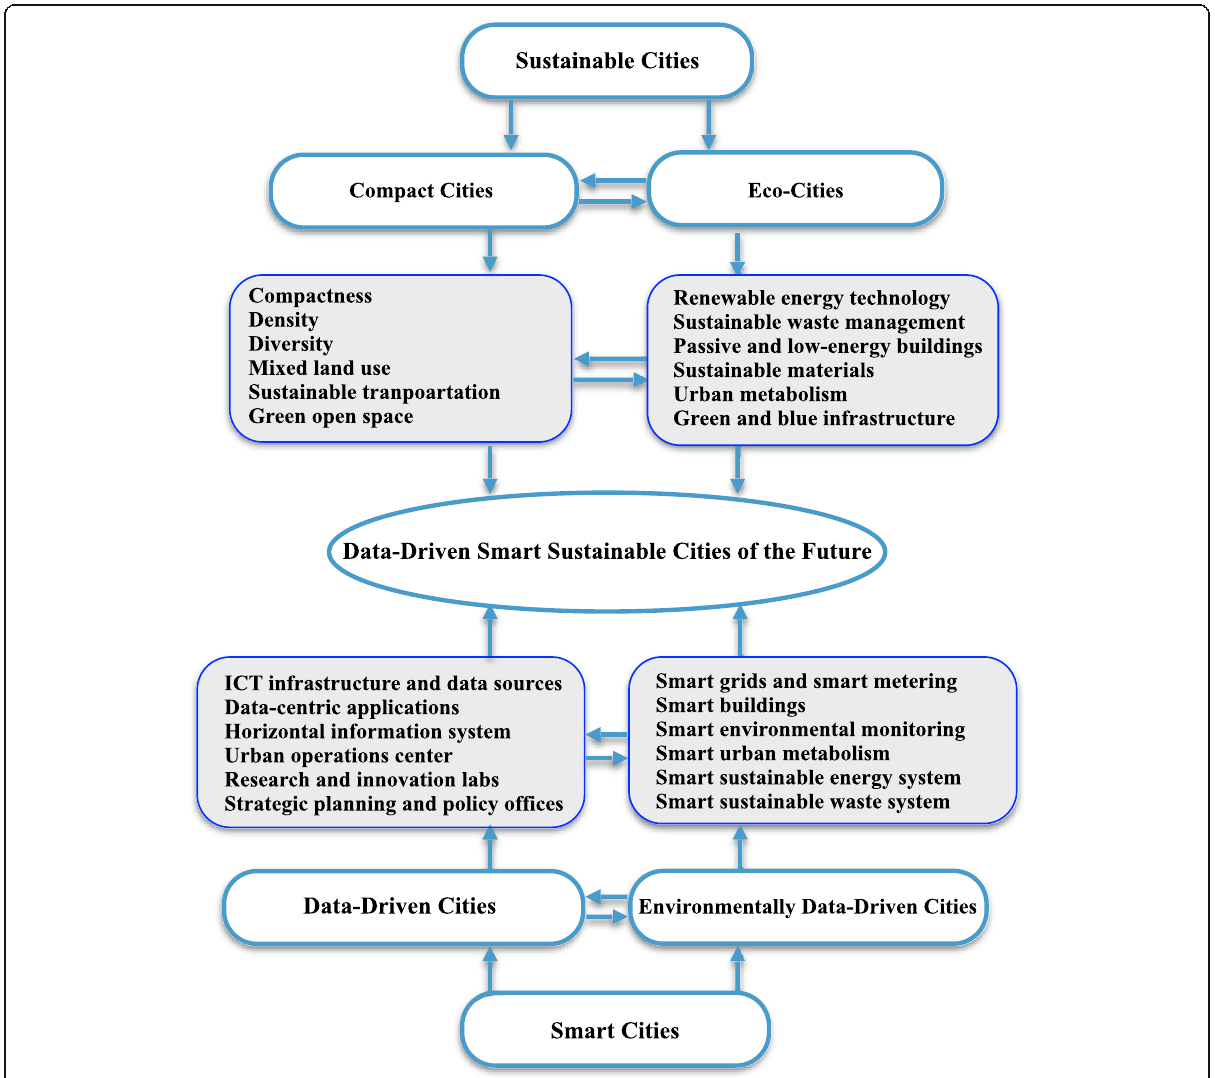
Fig. 1 An applied theoretical framework for strategic sustainable urban development